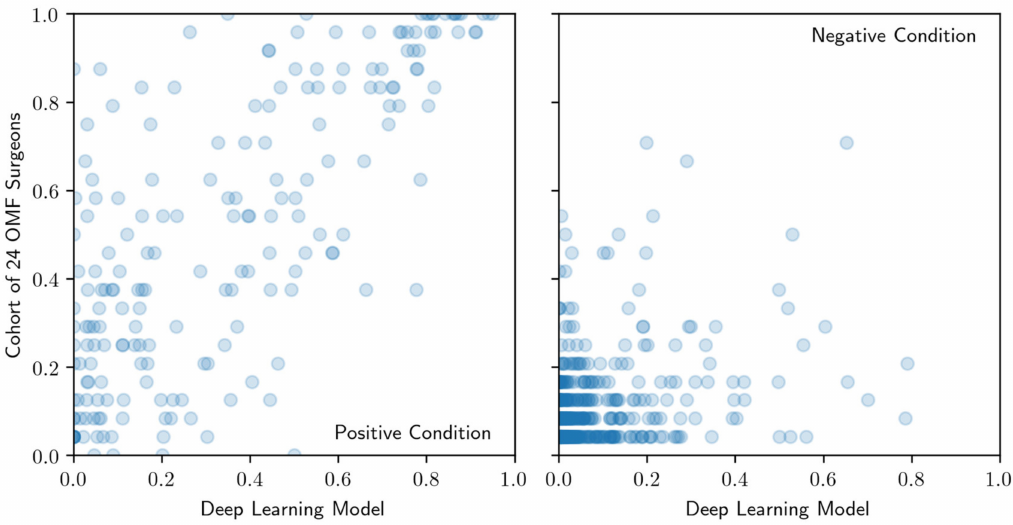
Figure 6. Comparison of confidence score rankings for positive condition cases (left) and negative condition cases (right) produced by the model (axis labeled Deep Learning Model) and cohort of OMF surgeons (axis labeled Cohort of OMF surgeons). Regions of interest that are scored most (least) likely to be a radiolucent periapical alteration have highest (lowest)